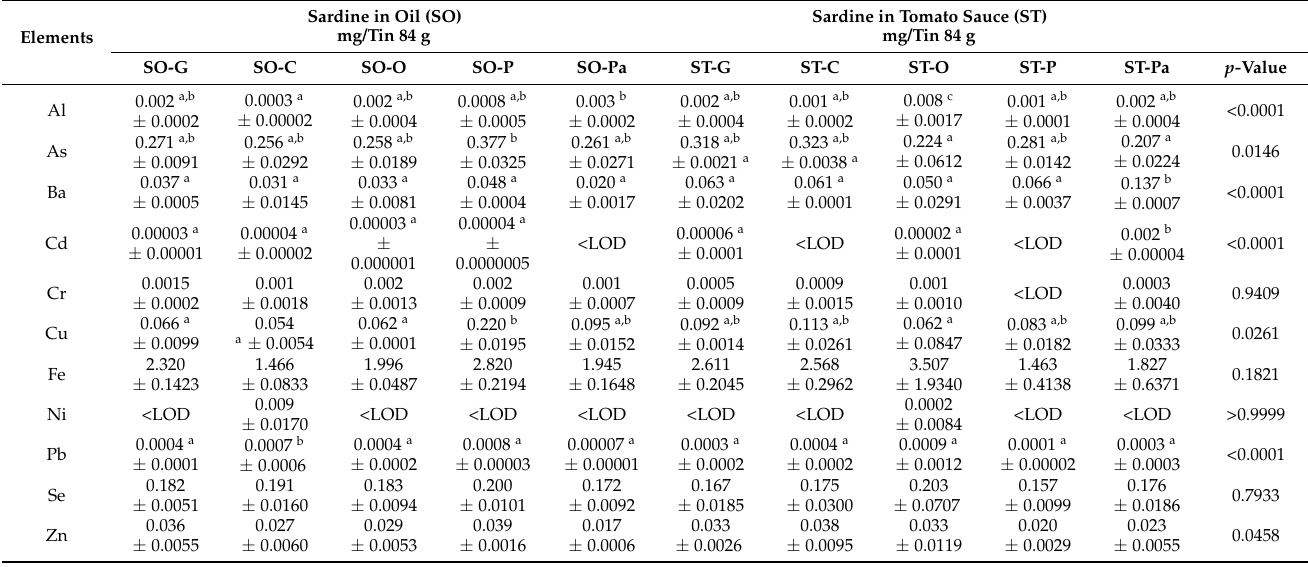
Table 4. Elemental content in canned sardines (mg/Tin 84